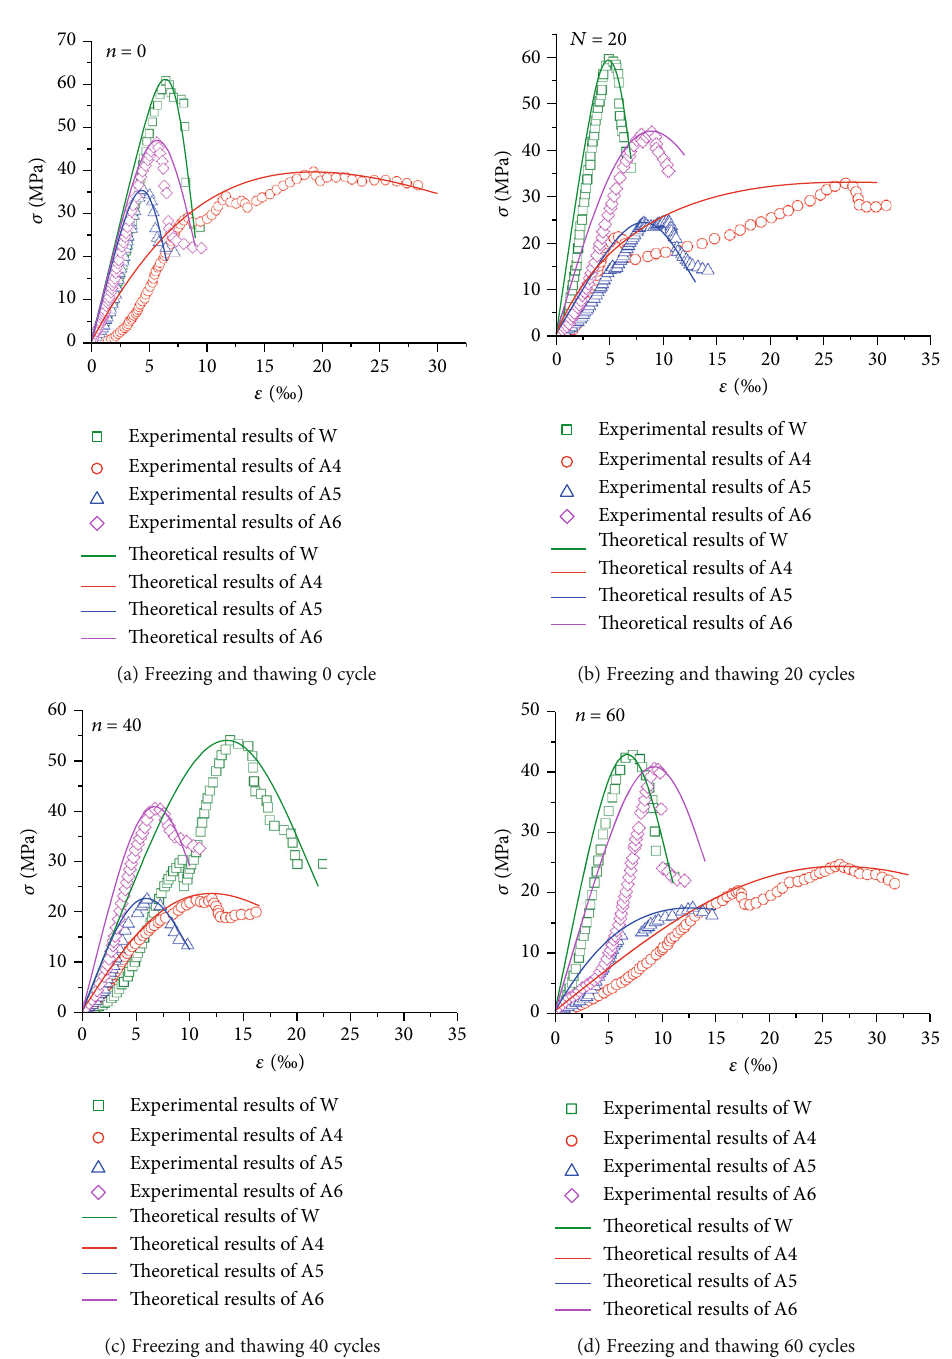
Figure 5: The conventional triaxial compression experimental data of rocks con fi ned by 2 MPa under freezing and thawing cycle